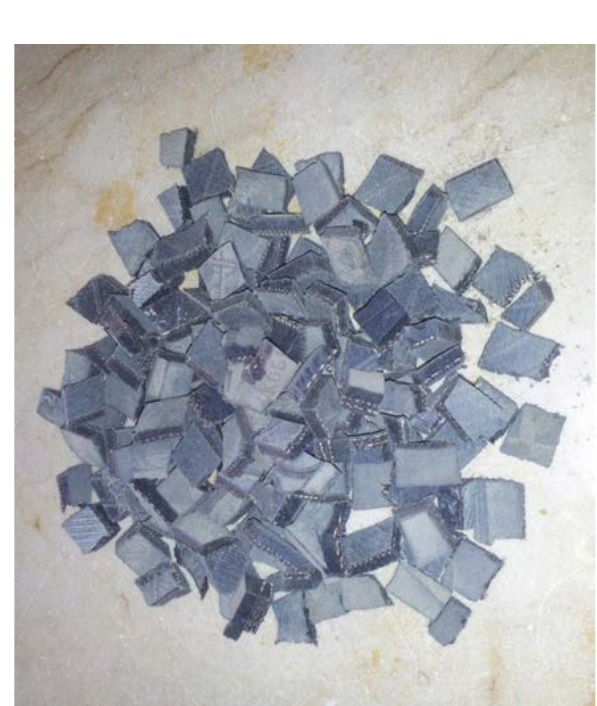
Figure 3. Shredded tyre chips. The dimensions of each chip are 20 × 15 × 0.5